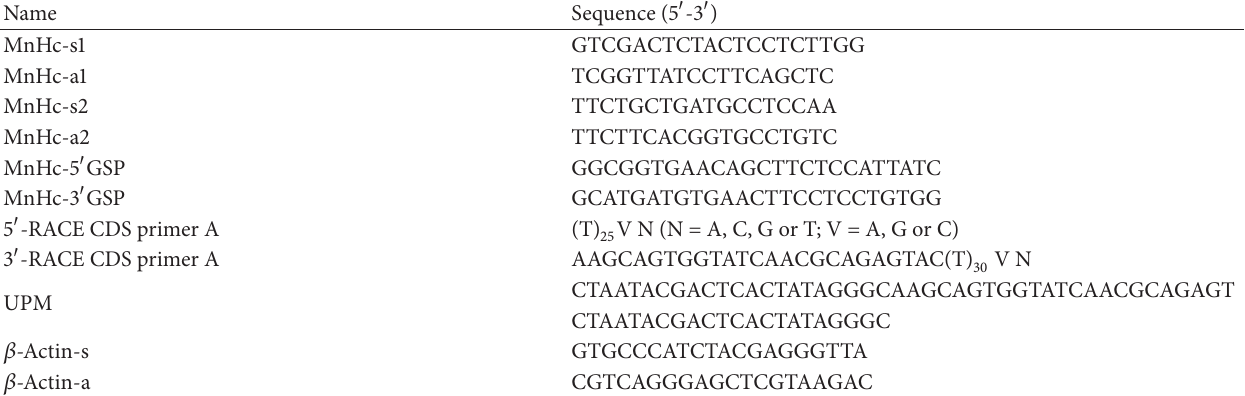
Table 2: Primers used in our